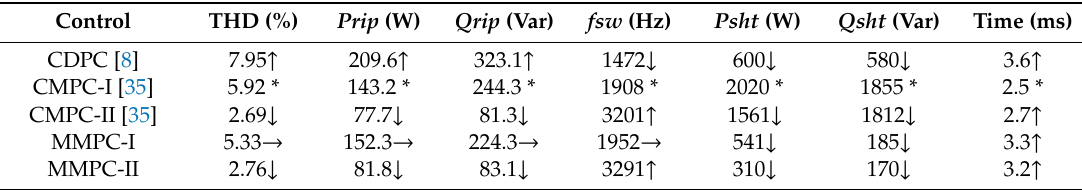
Table 2. Quantitative Comparison of Simulation